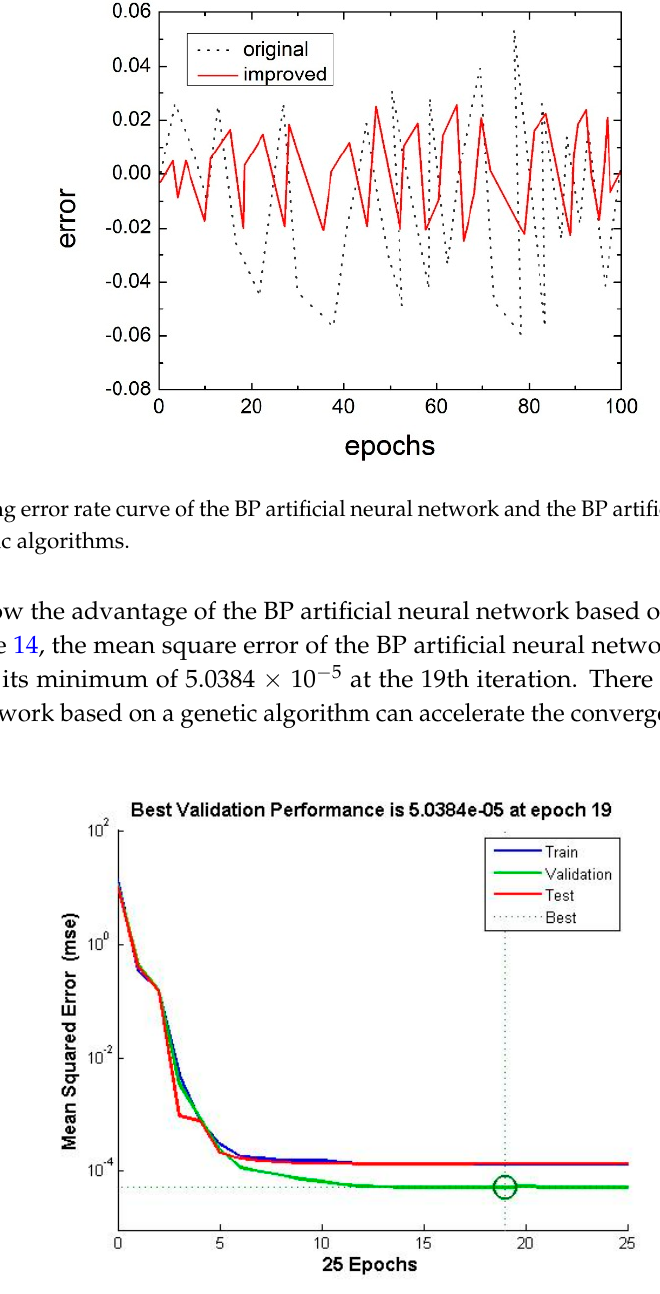
Figure 14. The mean square error curve of the BP artificial neural network based on a genetic algorithm.